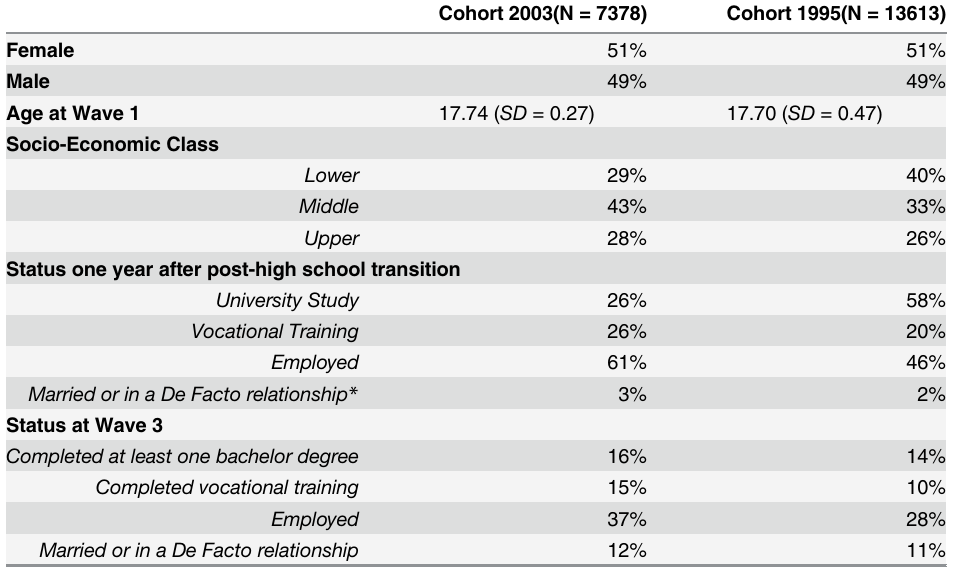
Table 1. Sample Characteristics for Both